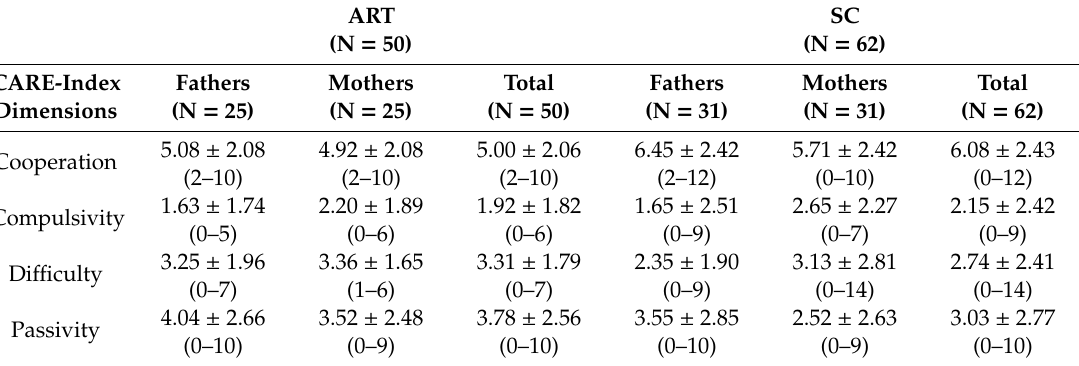
Table 5. Mean ± standard deviation (range) for interactive styles (CARE-Index dimensions) in ART and SC